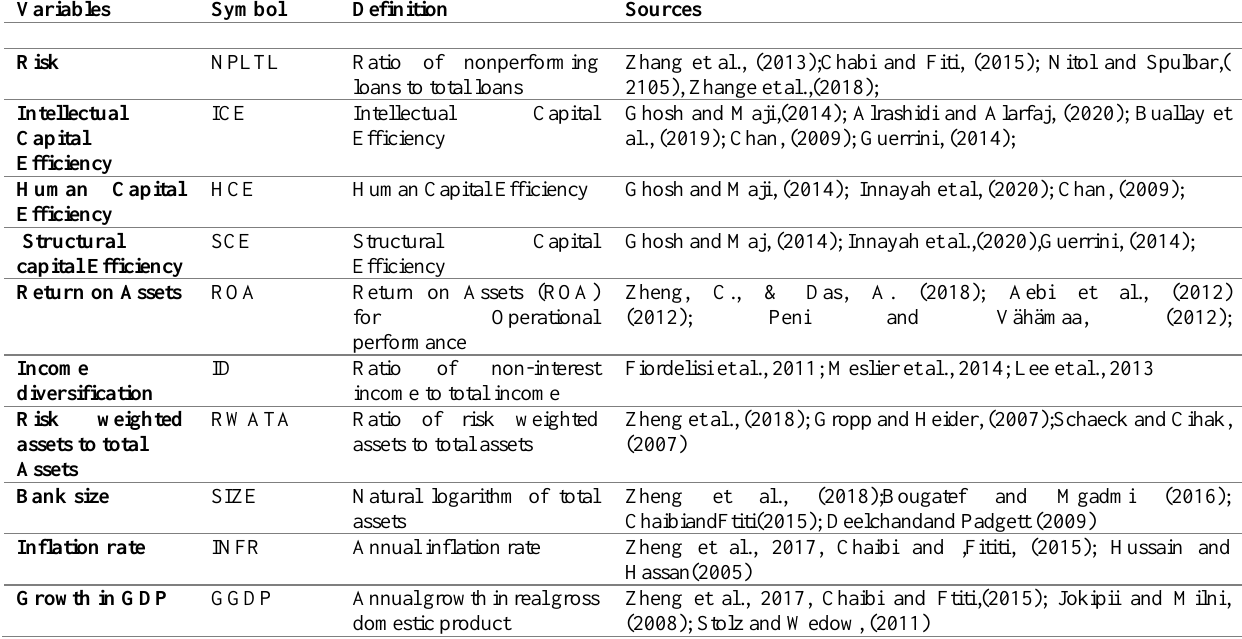
Table 1: Contains details about the source of variables